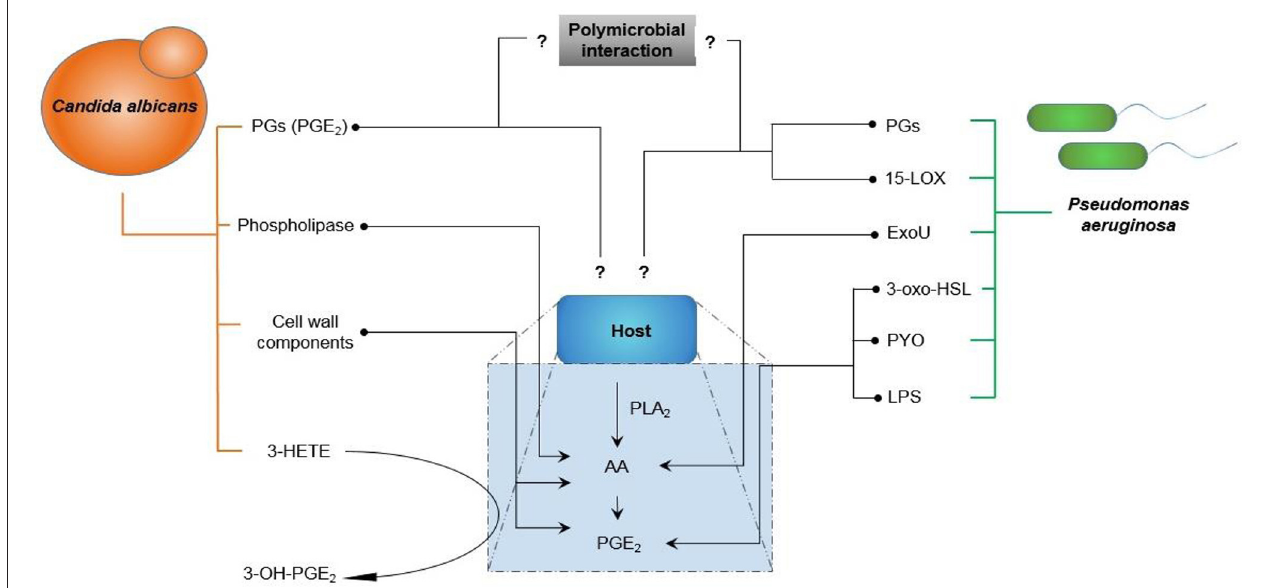
FIGURE 7 | Interaction of Candida albicans and Pseudomonas aeruginosa with host cells highlighting the production of eicosanoids. Arrows indicate production/increase. Question marks indicate uncharacterized interactions (AA, Arachidonic acid; PLA 2 ,Phospholipase A 2 ; PGs, Prostaglandins; PGE 2 , Prostaglandin E 2 ; ExoU, Exotoxin U; PYO, pyocyanin; LPS, lipopolysaccharide; 3-HETE, 3-hydroxyeicosatetraenoic acid; 3-oxo-HLS, 3-oxododecanoyl-L-homoserine lactone; 15-LOX,